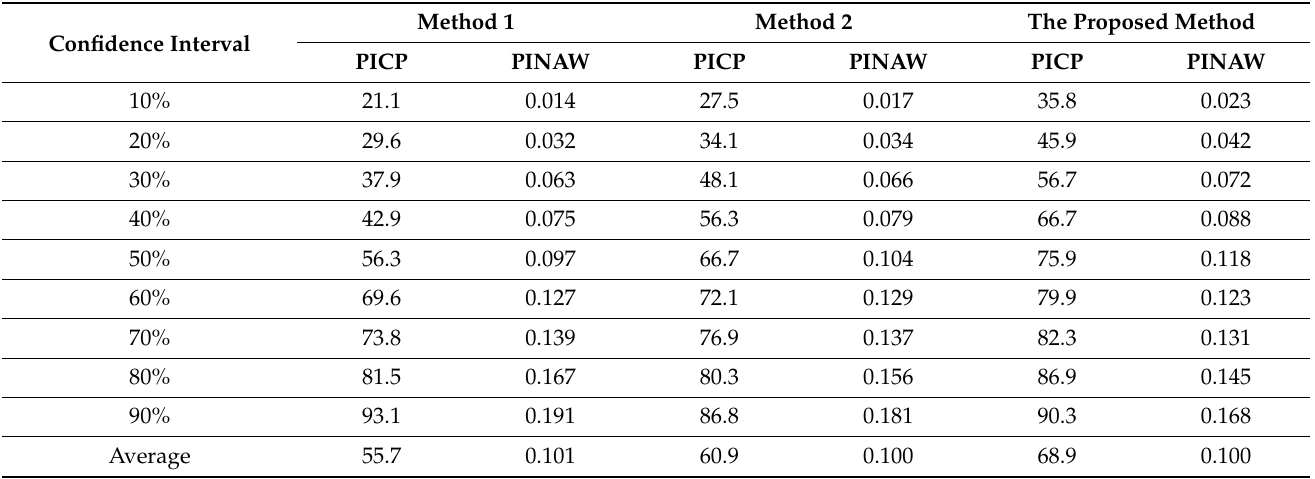
Table 7. Accuracy comparison with different interval prediction methods in Set